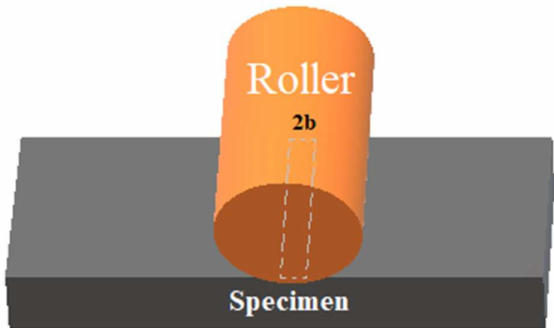
Figure 7. Contact area between the roller stamp and the